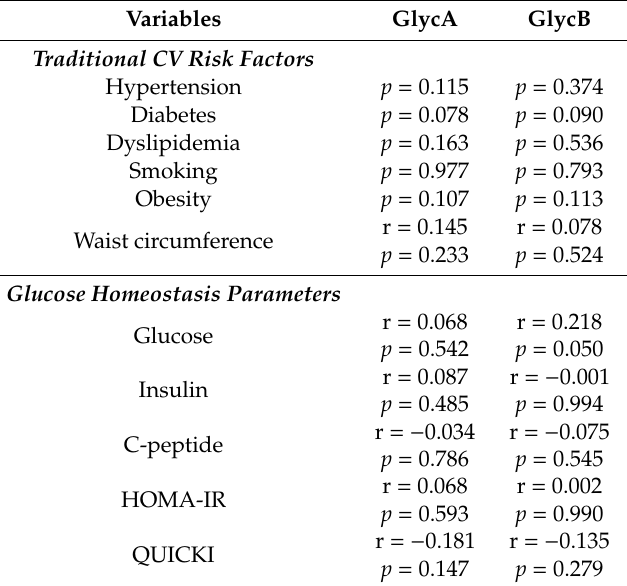
Table 2. Glycoproteins and cardiometabolic factors in early RA patients. Variables GlycA GlycB Traditional CV Risk Factors Hypertension p = 0.115 p = 0.374 Diabetes p = 0.078 p = 0.090 Dyslipidemia p = 0.163 p = 0.536 Smoking p = 0.977 p = 0.793 Obesity p = 0.107 p = 0.113 Waist circumference Glucose Homeostasis Parameters Glucose Insulin C-peptide HOMA-IR QUICKI